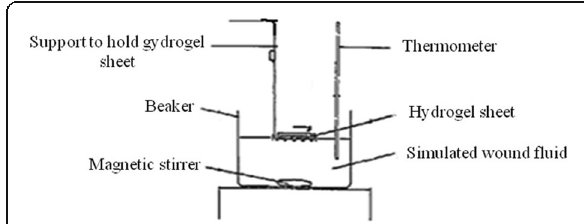
Fig. 1 Experimental set up for in vitro drug release study